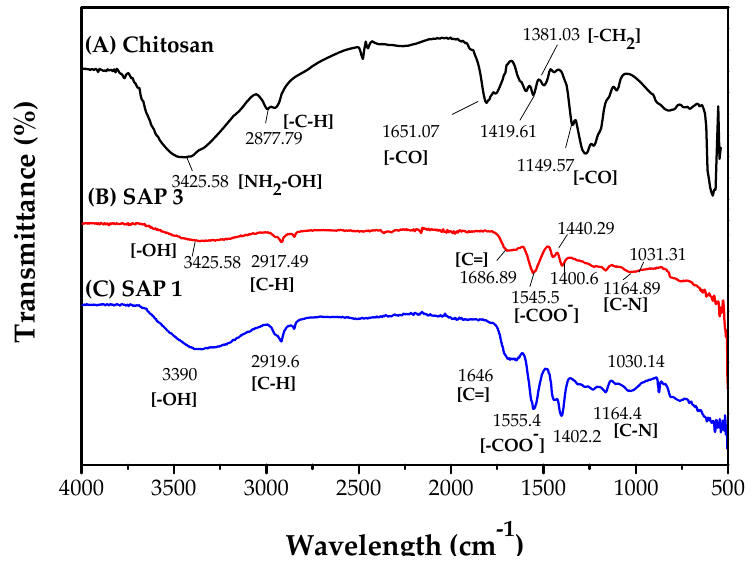
Figure 7. The IR analysis for ( A ) pure chitosan, ( B ) superabsorbent prepared using 0.5% ( w / v ) chitosan concentration (SAP 3), and ( C ) superabsorbent using 4% ( w / v ) chitosan concentration (SAP 1).